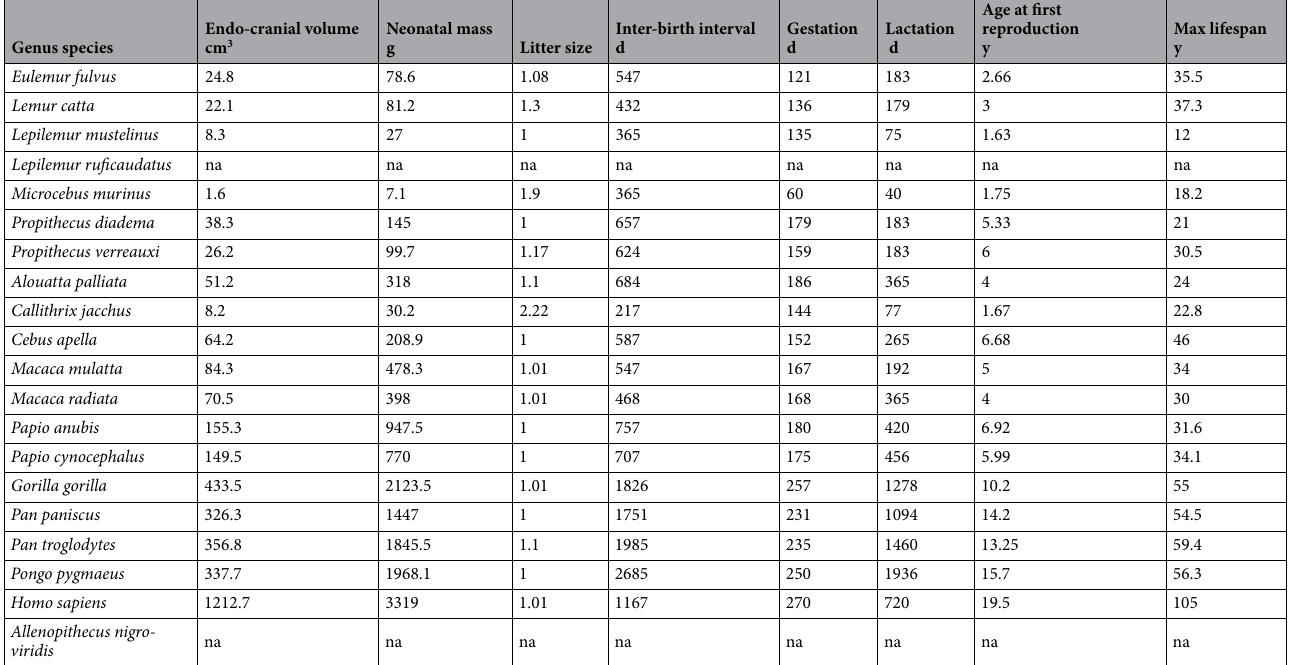
Table 2. Life history traits and brain size in selected primates. Brain size, age at first reproduction and maximal life expectancy are for females in species showing sexual dimorphism of body size. Otherwise, data are species means. Female body mass corresponding to life history variables and brain size in each species is documented in 2